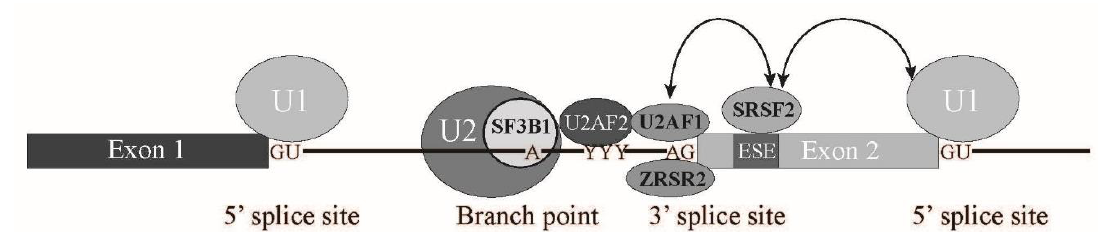
Figure 5. A scheme for early splicing step with splicing factors mutated in MDS on pre-mRNA. The names of four splicing factors whose mutations were frequently observed in Myelodysplastic syndrome (MDS) are shown in black bold. letters. Interestingly, these splicing factors are involved in 3 (cid:48) splice site and exon recognition during splicing reaction. Arrows indicate protein-protein interaction through an Arginine-Serine-rich (RS) domain. ESE: exonic splicing enhancer, U1, U2: U1 small nuclear ribonucleoprotein, U2 small nuclear